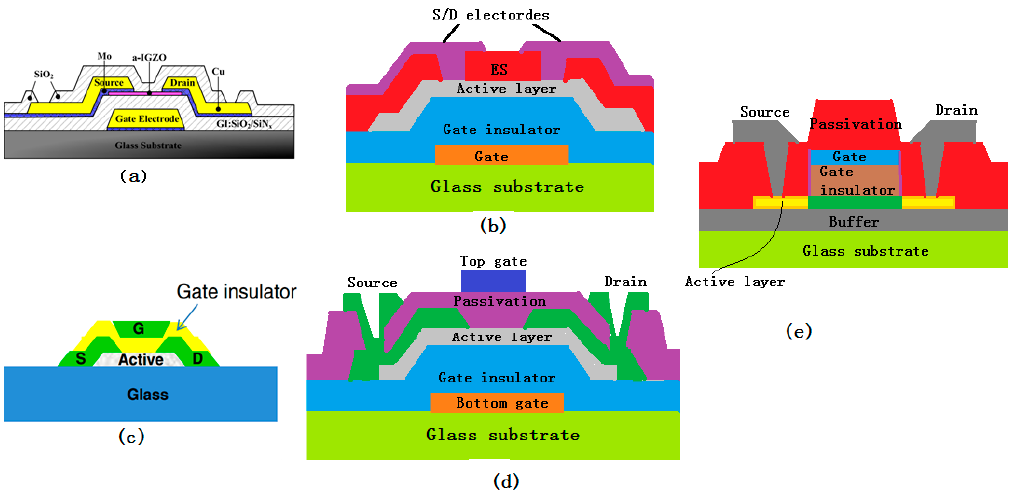
Figure 1. Typical device configurations of oxide semiconductors: ( a ) back channel etch (BCE) structure, ( b ) etch stop (ES) structure, ( c ) top gate (TG) structure, ( d ) dual gate (DG) structure, ( e ) co-planar (CP)